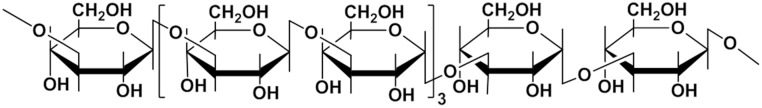
The chemical structure of the repeated unit of salecan.